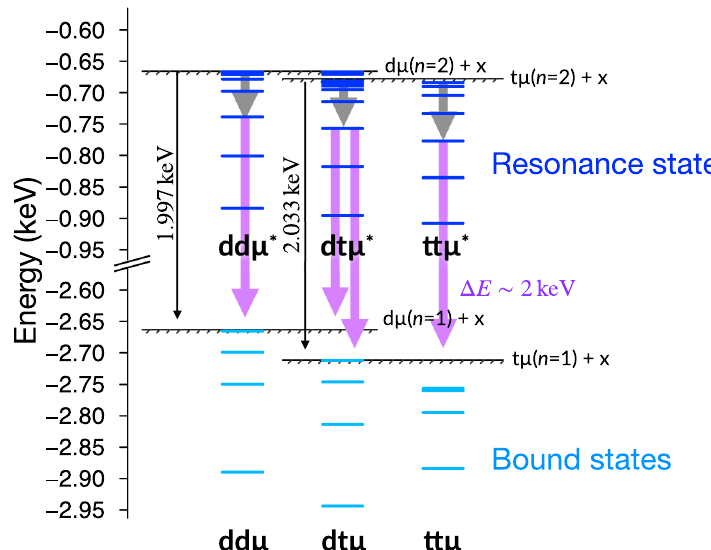
Figure 1. Energy level diagram of resonance states (restricted to rotationally ground state and its vibrational excited states ) and bound states (all rovibrational states) of muonic molecules. The hatched areas indicate the VM range 5 eV below the threshold energy. x denotes d or